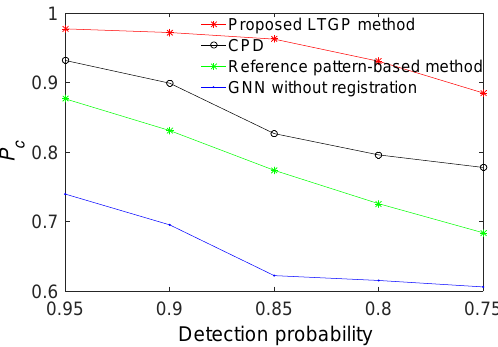
Figure 7. Correct association probabilities of GNN without registration, reference pattern-based algorithm, CPD algorithm and the proposed method for different detection probabilities.